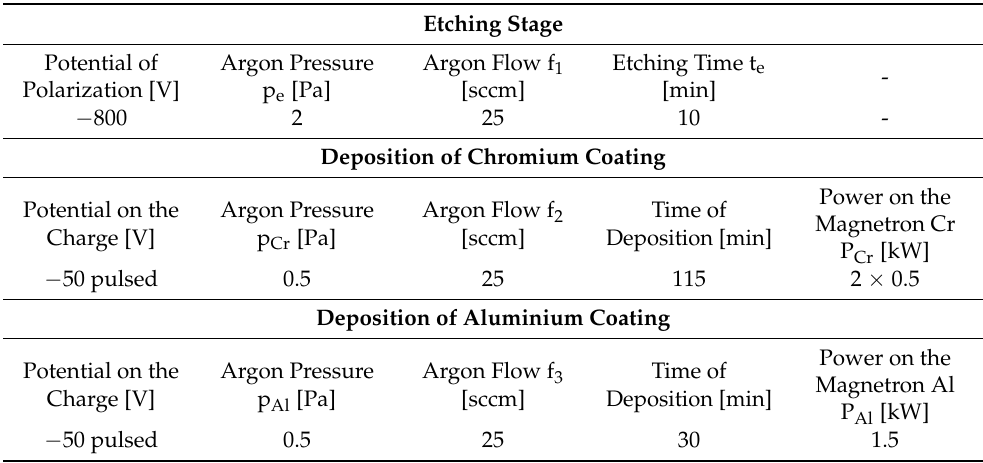
Table 2. Parameters of magnetron sputtering stages for aluminum and chromium coatings.